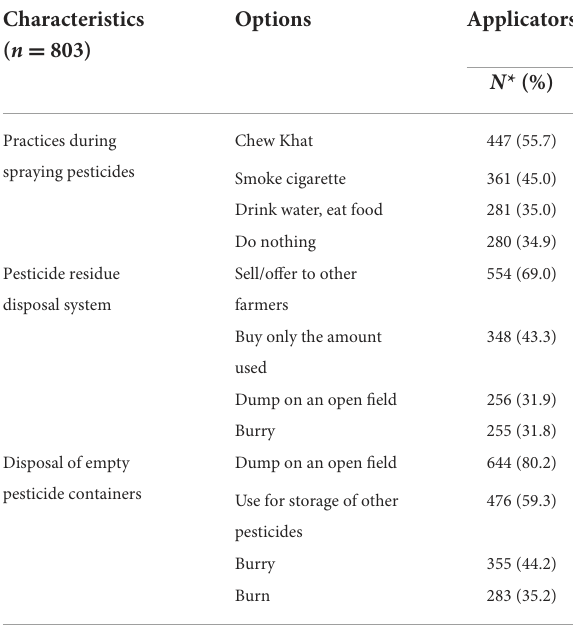
TABLE 8 Hazardous practices of applicators during spraying and disposal of pesticides in East Hararge Zone, Oromiya Region, Ethiopia.